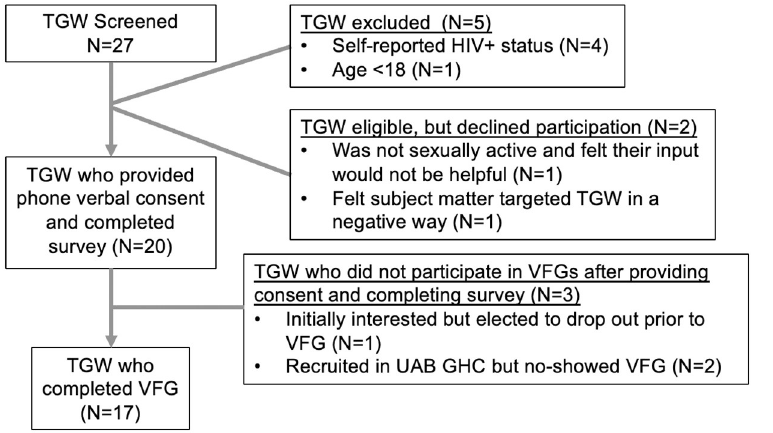
Fig 1. Flow diagram of screening and enrollment of transgender women for virtual focus